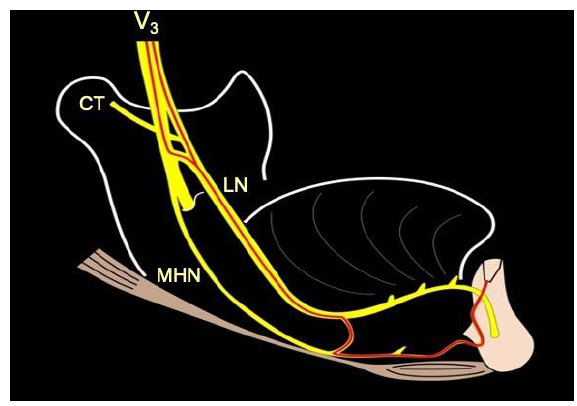
Figure 3. Schematic illustrating the anastomosis between the lingual nerve and the nerve to the mylohyoid. Due to this possible anatomy, the nerve to the mylohyoid could be responsible for the sensibility of the mandibular symphysis.